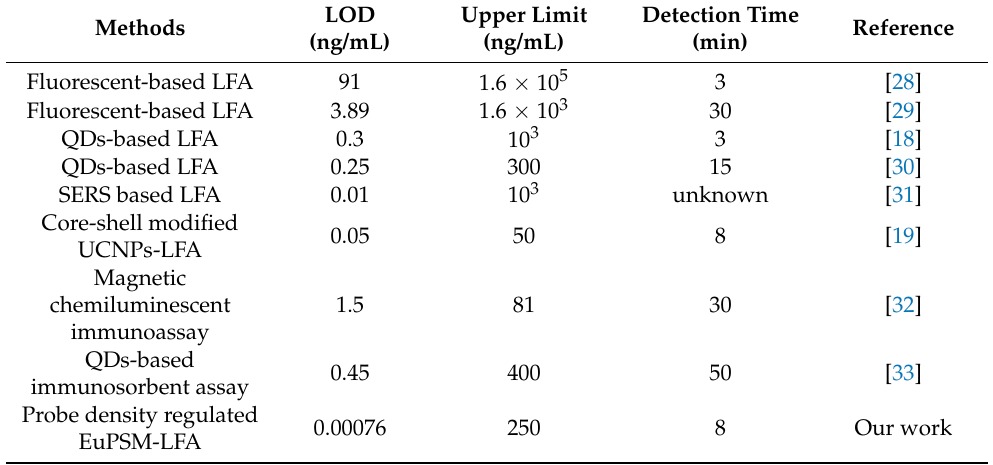
Table 1. Comparison of detection performance through different POCT methods for CRP detection.